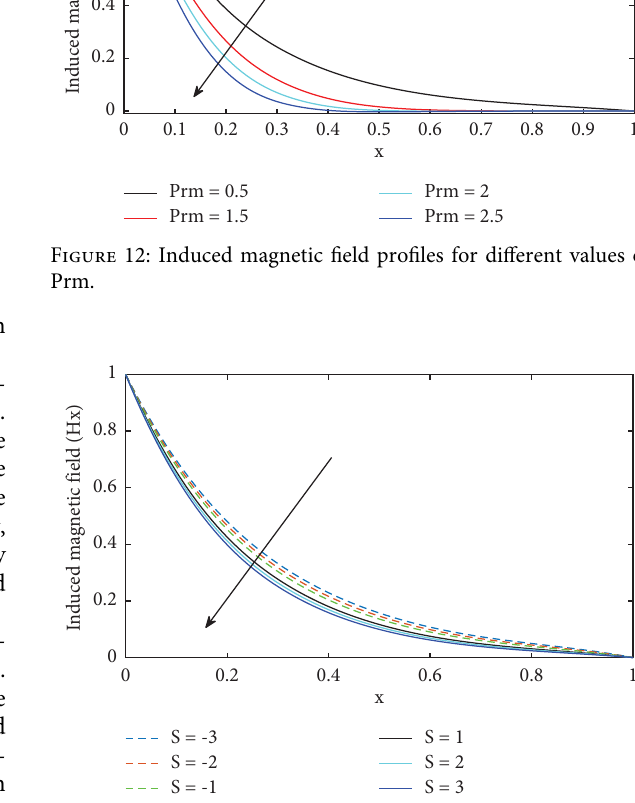
Figure 13: Induced magnetic feld profles for diferent values of S